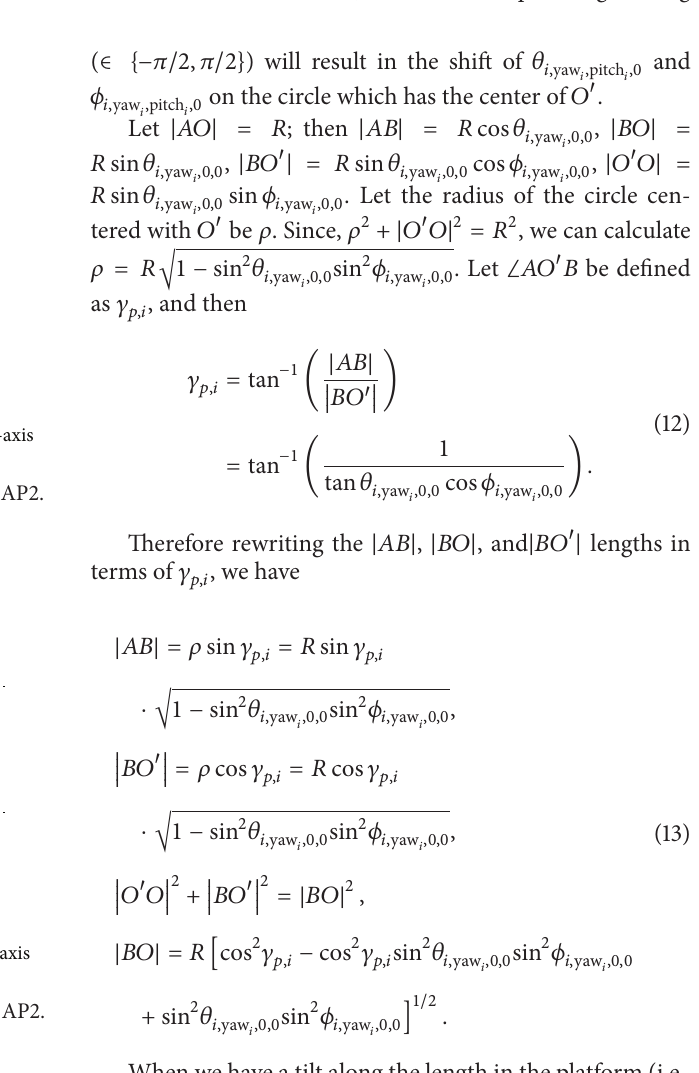
𝜙 𝑖 , 𝑖 = 1, 2 . 𝑖, yaw , pitch 𝑖 ,0 according to the pitch values of AP 𝑖 In order to present the effect of pitch on the angle, observe and 𝜙 𝑖, , 𝑖 = 1, 2 , be the angles Figure 6. Let 𝜃 𝑖, yaw 𝑖 ,0,0 yaw 𝑖 ,0,0 calculated according to (11) which can be described with the point 𝐴 in Figure 6. Then the platform’s change of pitch